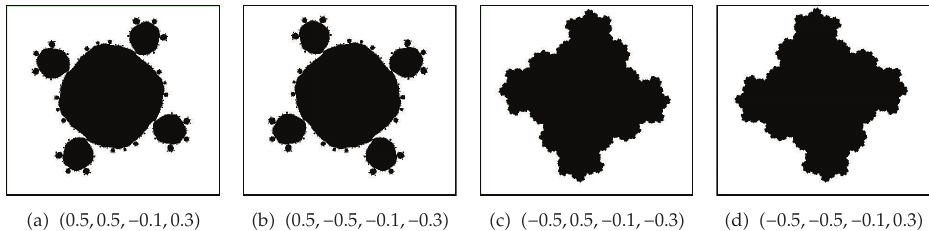
Figure 8: The generalized J sets perturbed by additive noise when α (cid:6) 4.